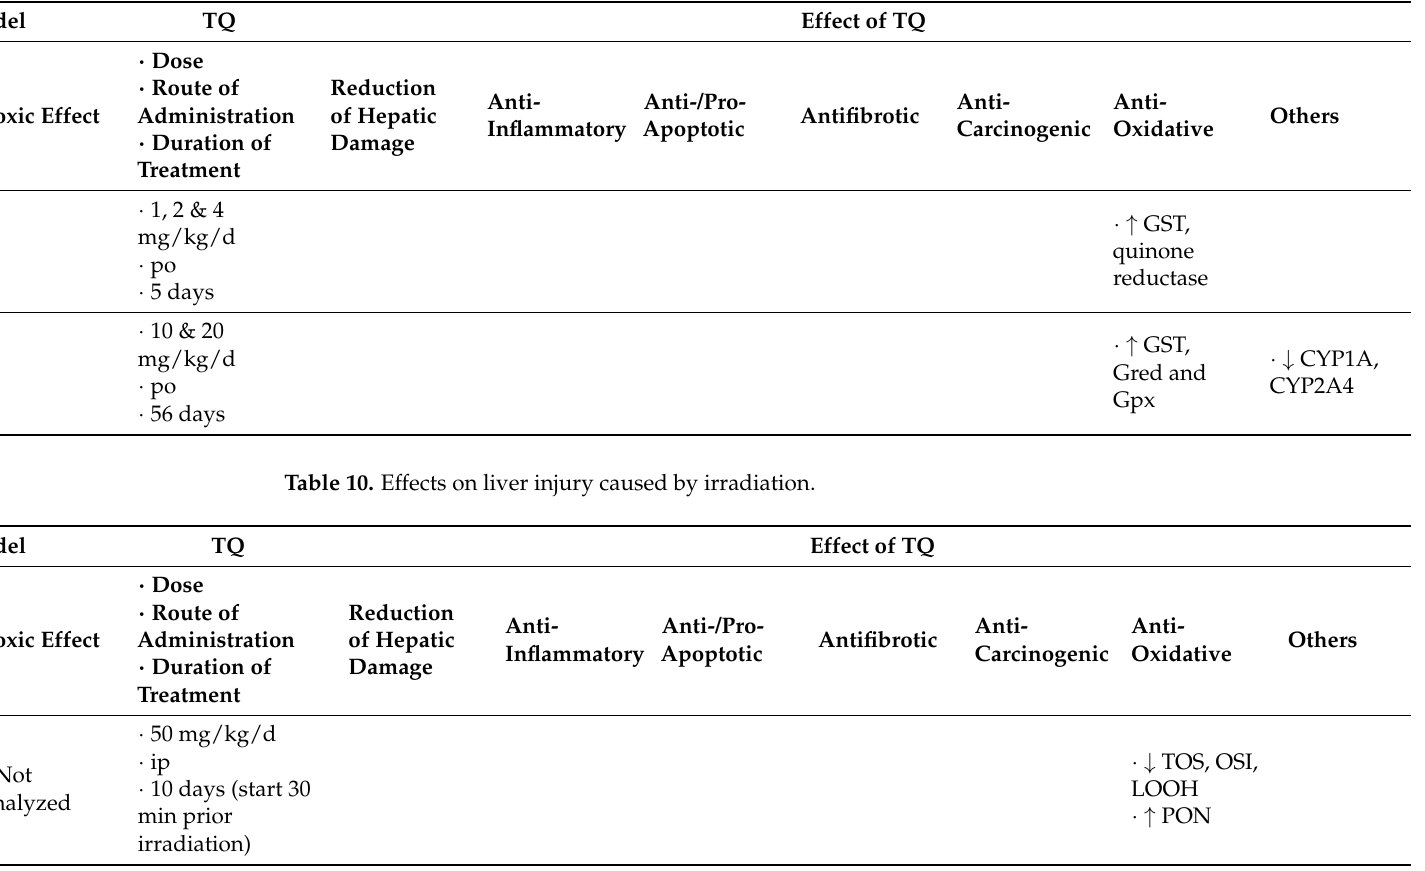
Table 9. Effects on healthy liver.